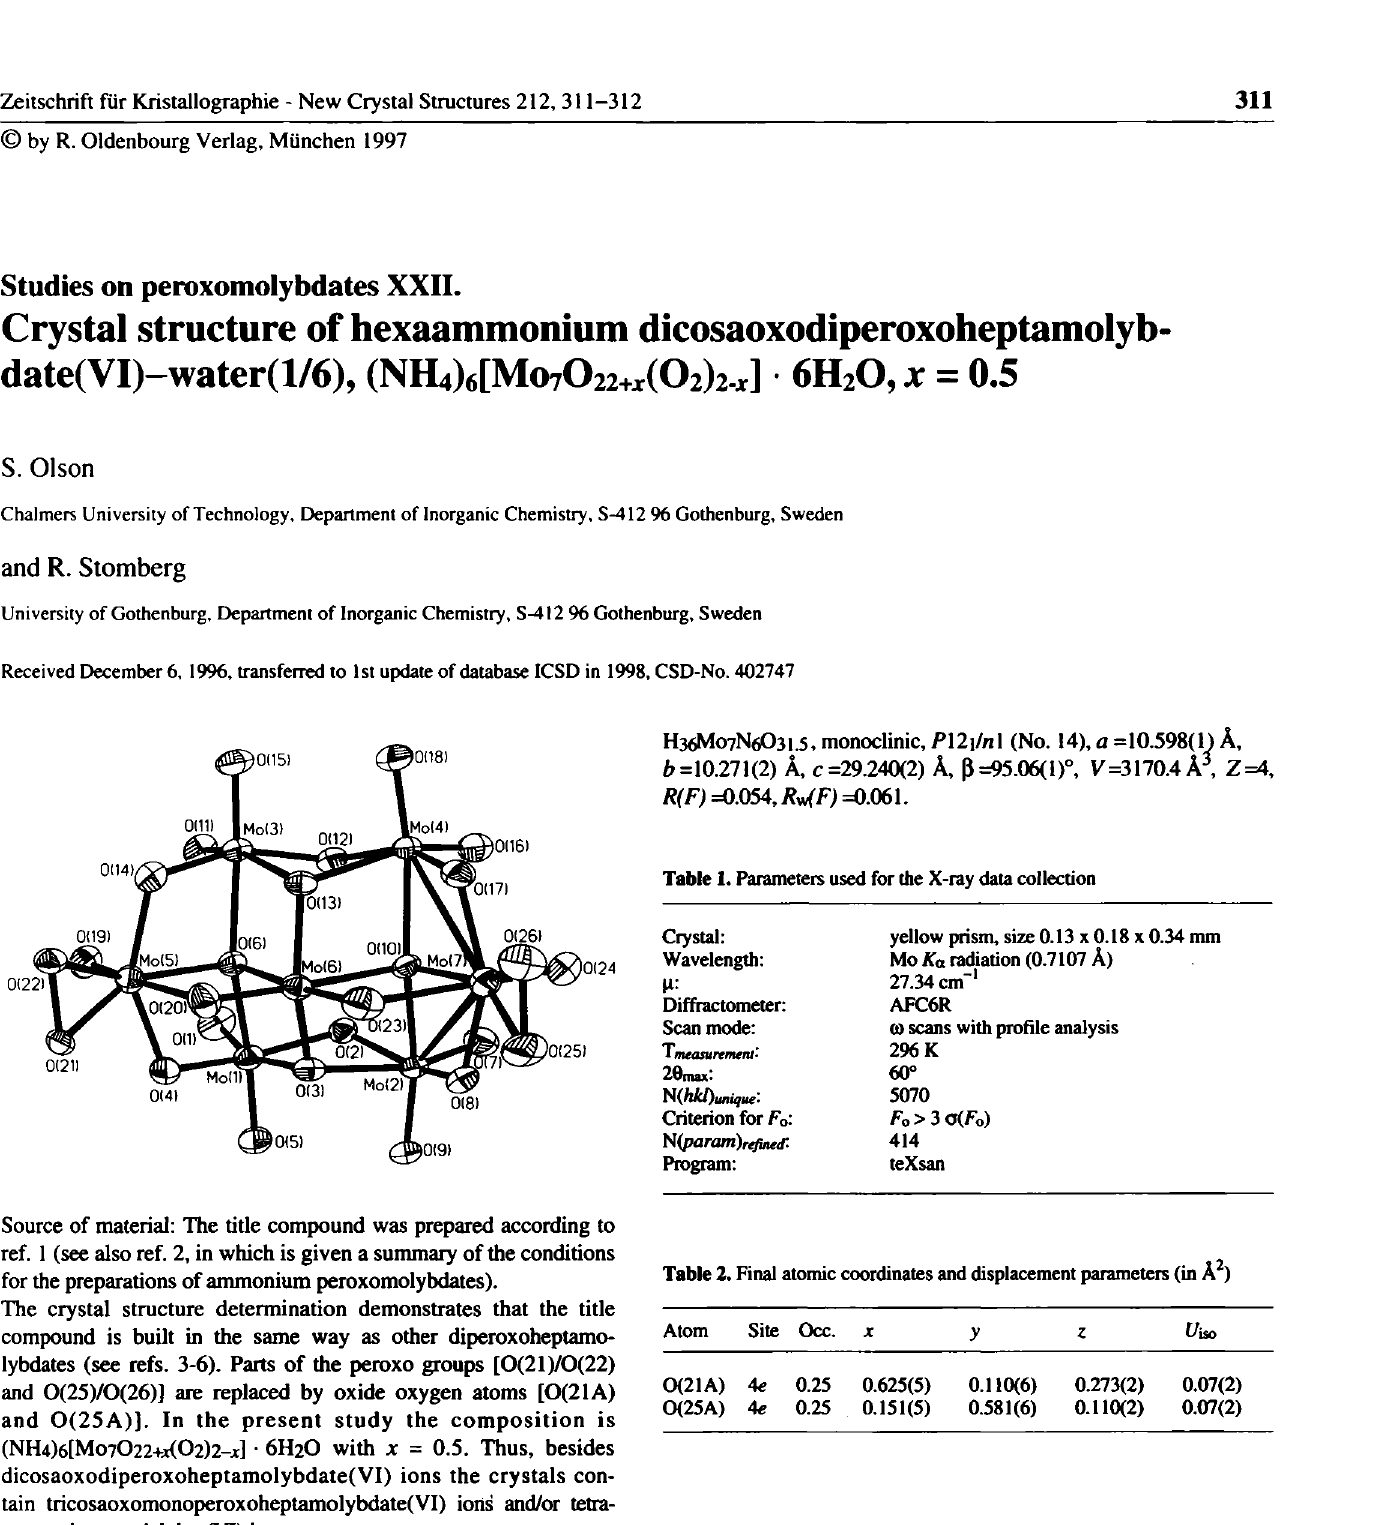
Table 3. Final atomic coordinates and displacement parameters (in Â 2 ) Atom